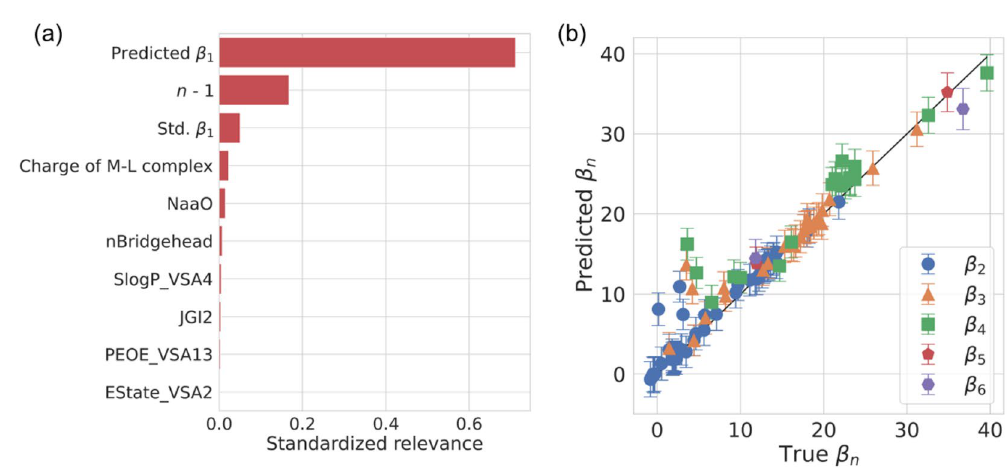
Figure 4. ( a ) The top 10 highest ranked features through sensitivity analysis using a Kullback–Leibler divergence as a measure for predicting multi-order β n . ( b ) Parity plot between true and predicted multi-order β n values of the validation data using the best GPR model. Error bars indicate 1σ uncertainty of the predicted